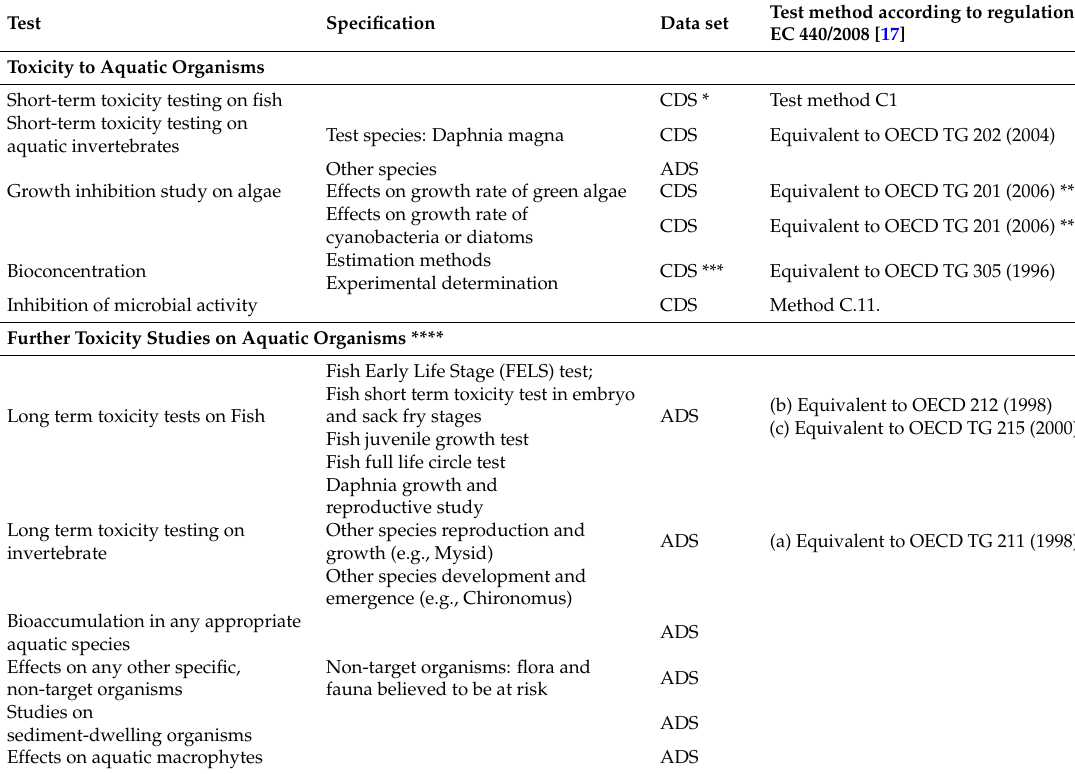
Table 1. Information requirements according to Annex II of the Biocidal Product Regulation for ecotoxicity testing, including corresponding test methods as set out in Regulation EC 440/2008 (CDS = Core Data Set, ADS = Additional Data Set, TG = Test Guideline). Data from